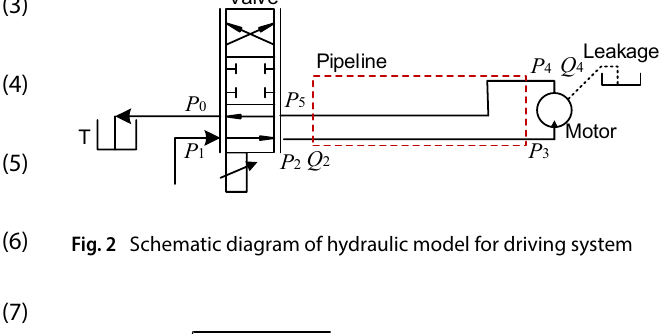
Fig. 2 Schematic diagram of hydraulic model for driving